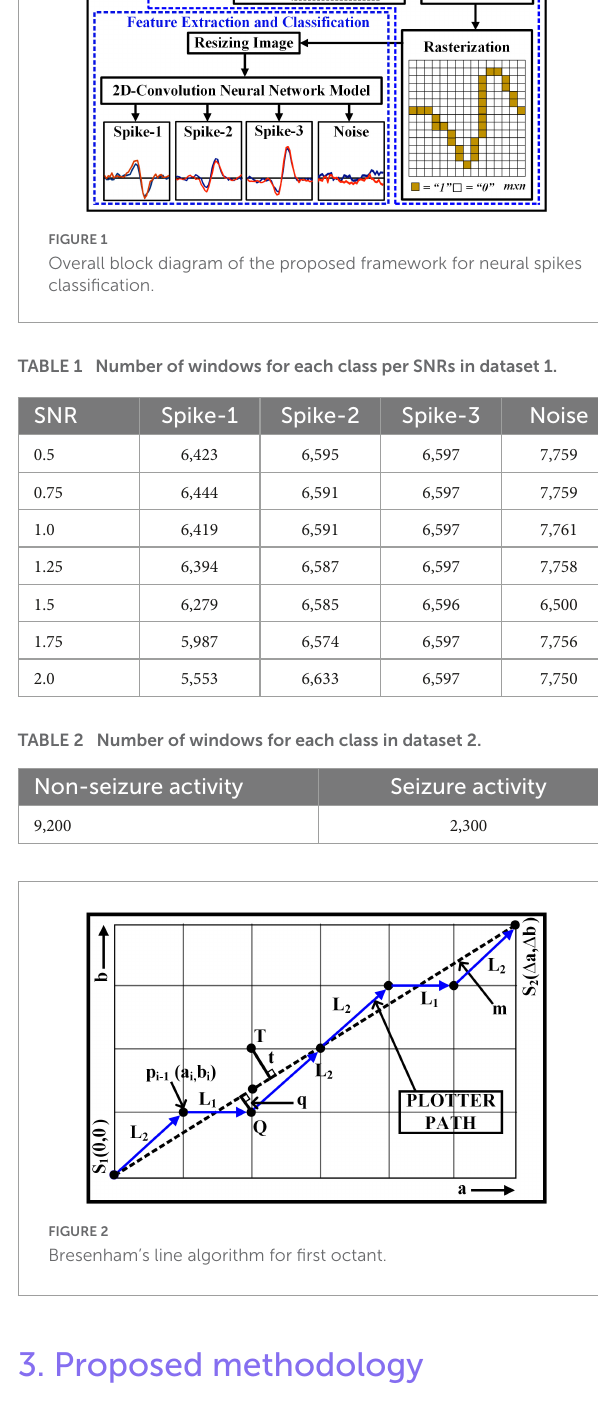
FIGURE2 Bresenham’s line algorithm for first